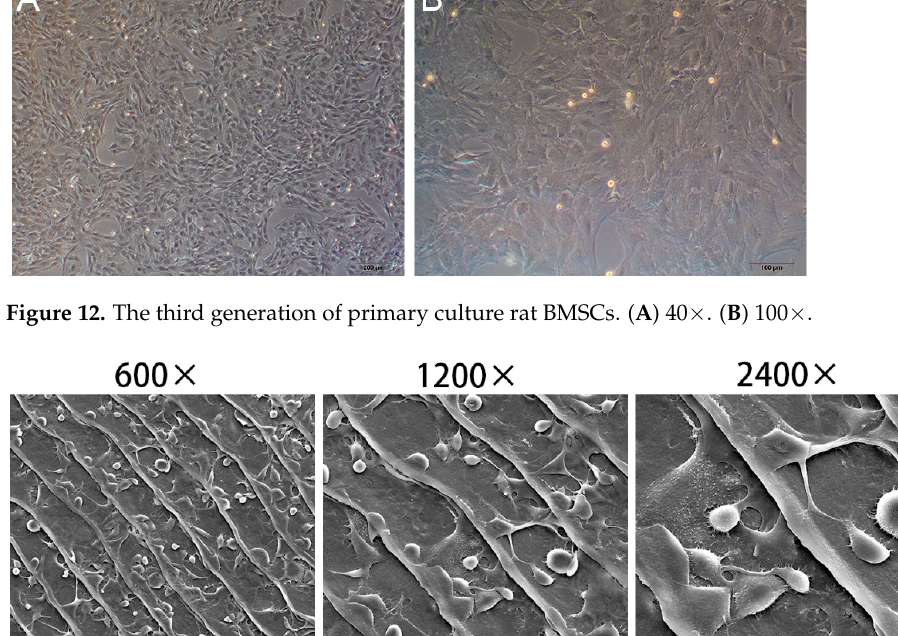
Figure 13. BMSCs adhered to the surface of fish scale collagen lamellar matrix after 3 h of cultivation.